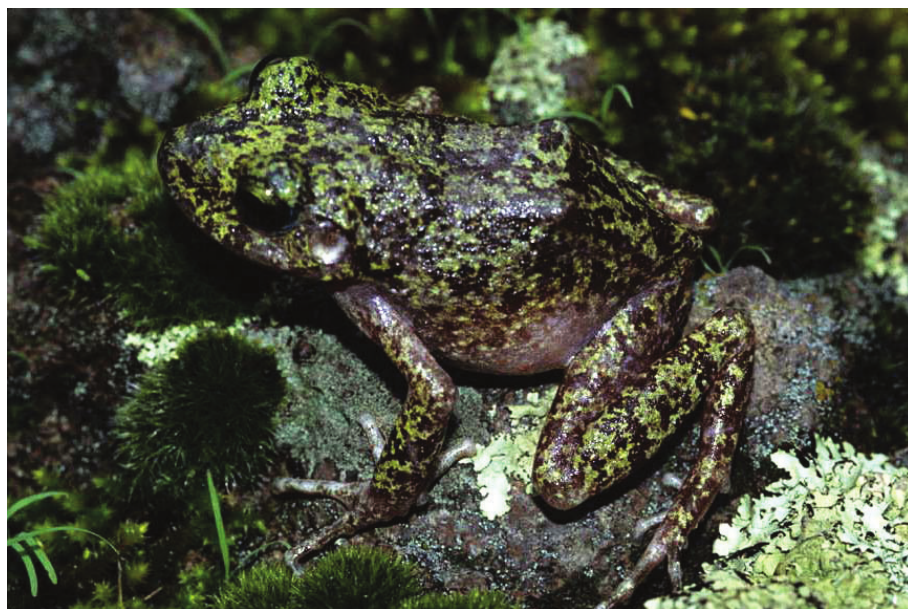
Figure 2. Craugastor tarahumaraensis . Ocampo, Chihuahua. Photo courtesy of Peter Heimes.